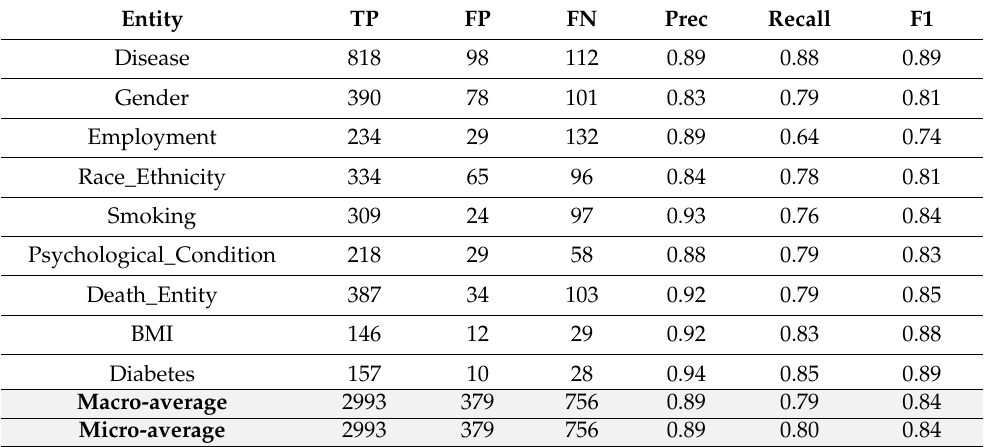
Table 6. Performance of most used entity from random 500 case reports.